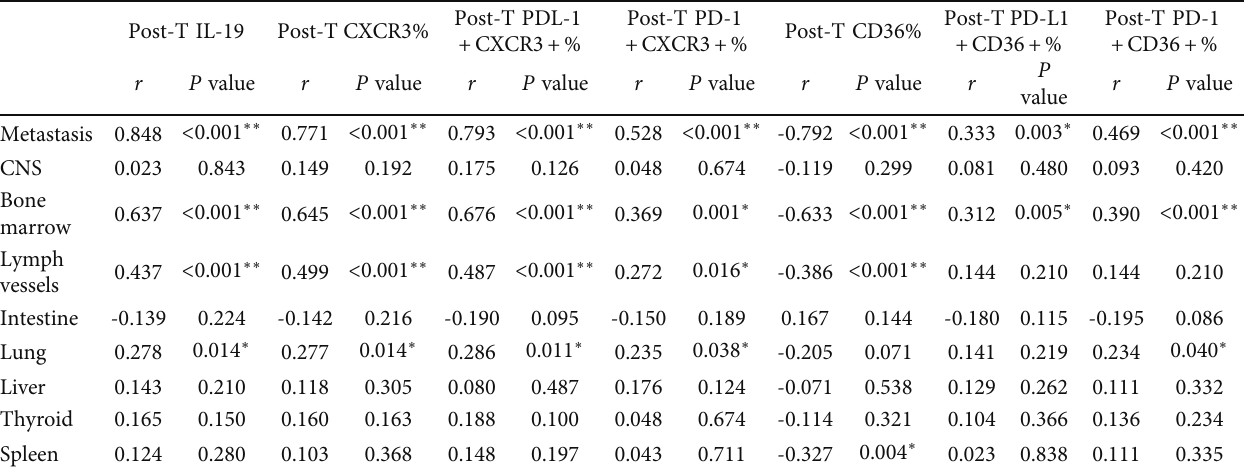
Table 5: Correlations between PD-L1/PD-1 coexpression with CXCR3/CD36, IL-19, and di ff erent sites of extranodal involvement in lymphoma. Post-T: posttherapy; CNS: the central nervous system. ∗ identi fi es signi fi cant di ff erences at P < 0 : 05 ; ∗∗ identi fi es high signi fi cant di ff erences at P < 0 : 001